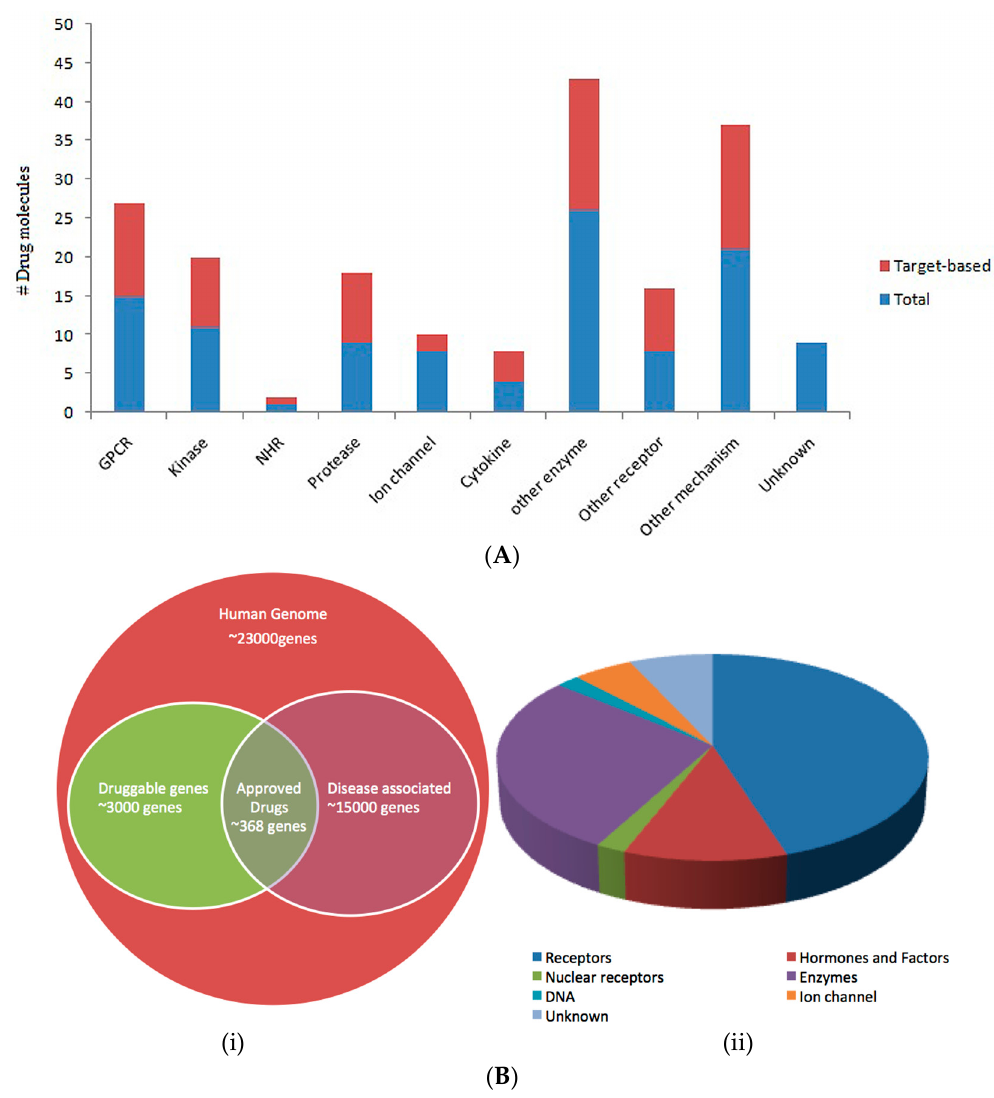
Figure 2. ( A ) Classification of drug targets based on FDA approved drug molecules [16]; ( B ) Druggable genome. (i) The Venn diagram shows the subset of human genome associated with disease and available drugs targeting subset of genes. (ii) Classification of the drug targets encoded by the human genome.